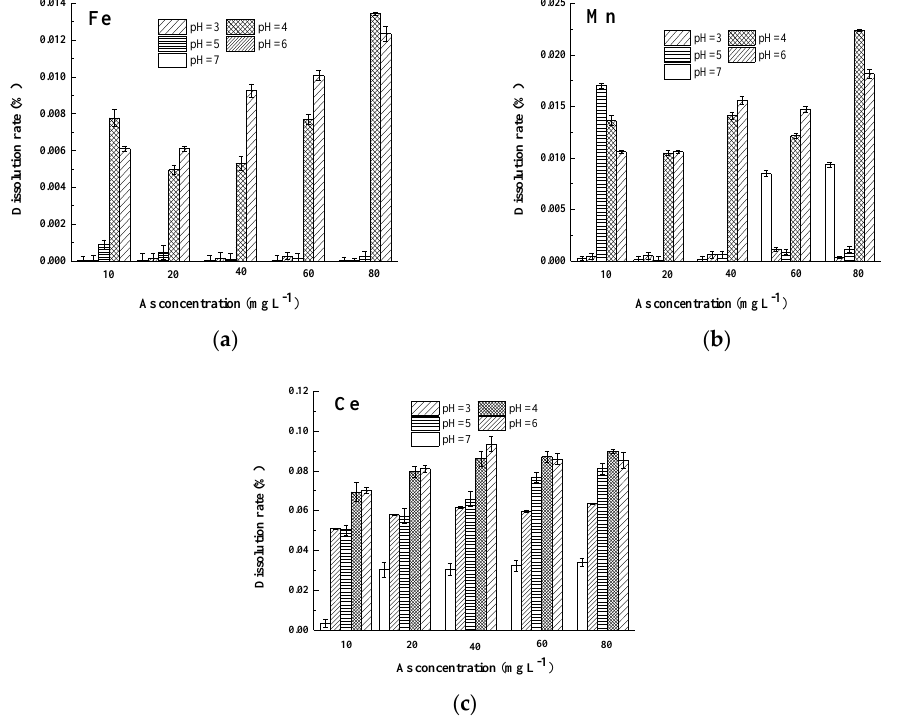
Figure 9. The dissolution rate of Fe ( a ), Mn ( b ), and Ce ( c ) after As(III) adsorbed by